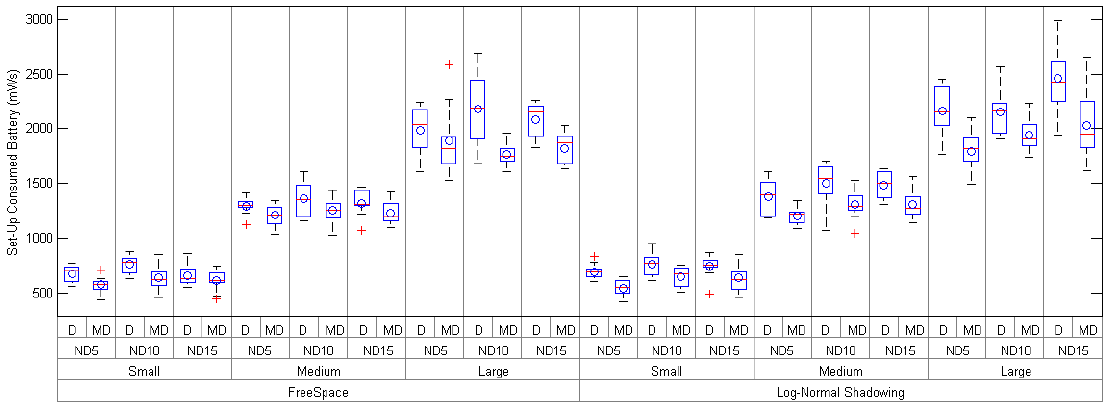
Figure 7. Average battery consumed during the network set-up of Daral (D) and mDaral (MD) for small-, medium- and large-size scenarios under different propagation conditions and node densities (ND5, ND10 and ND15).